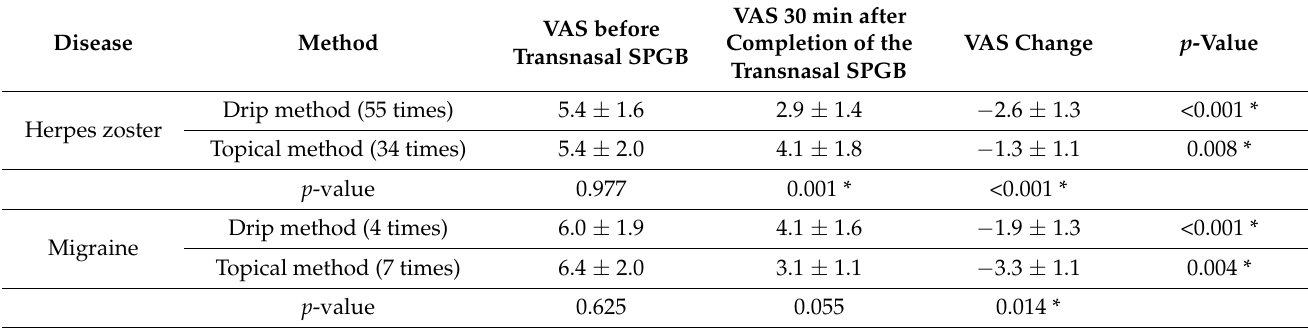
Table 5. Comparison of VAS scores between drip and topical methods in herpes zoster and migraine.